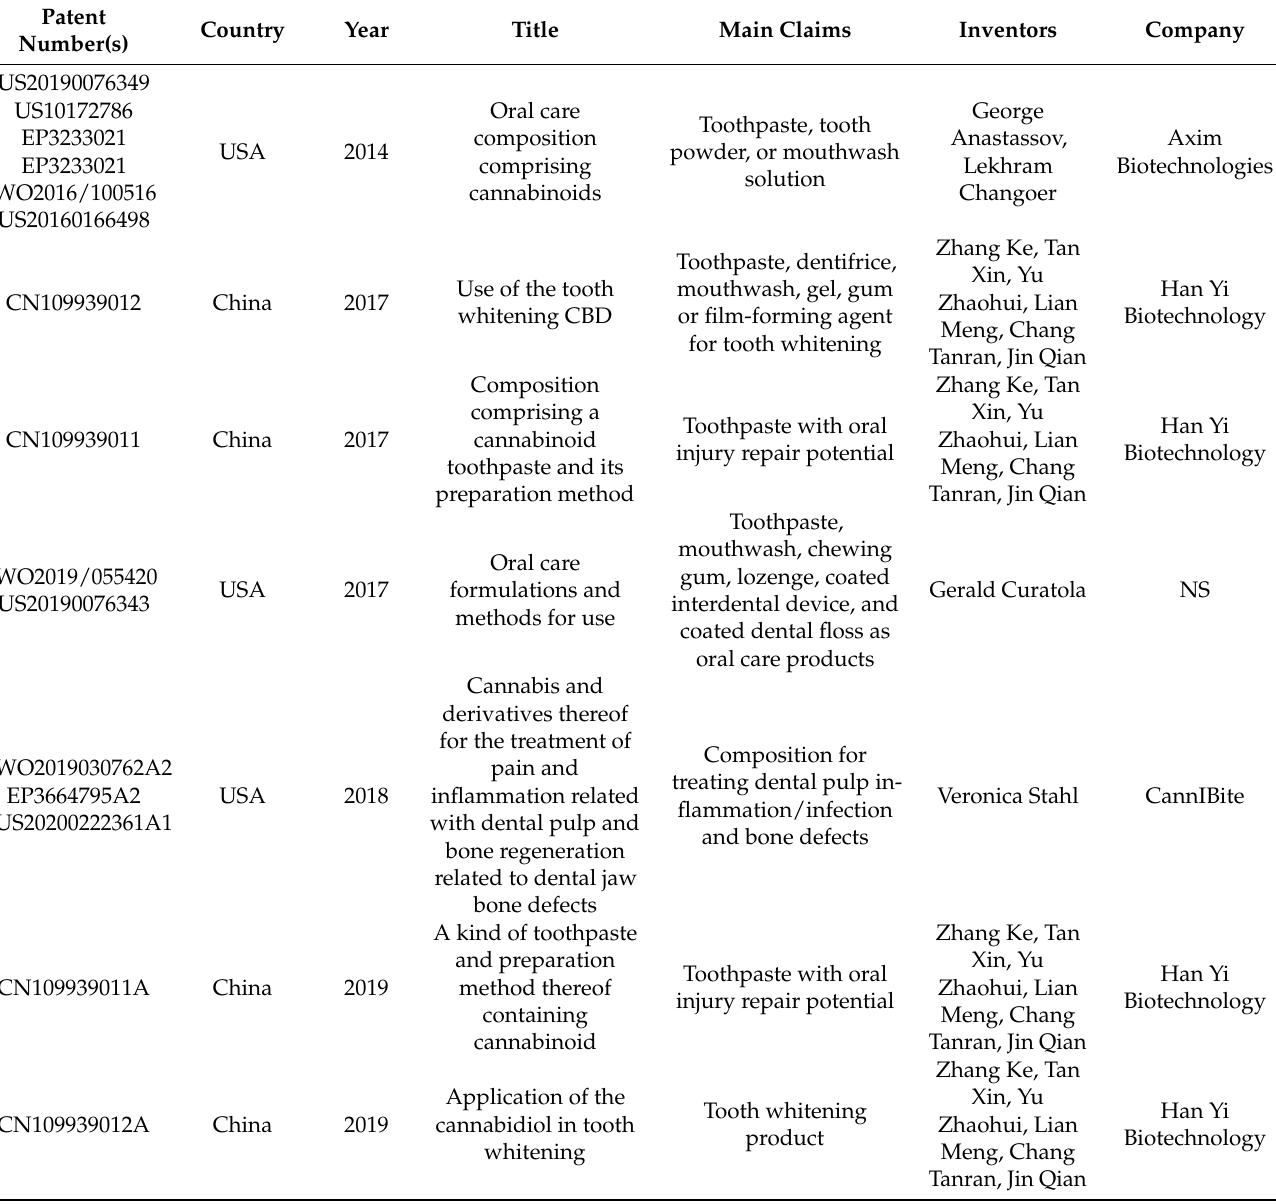
Table 3. Characteristics of the patents included, n =